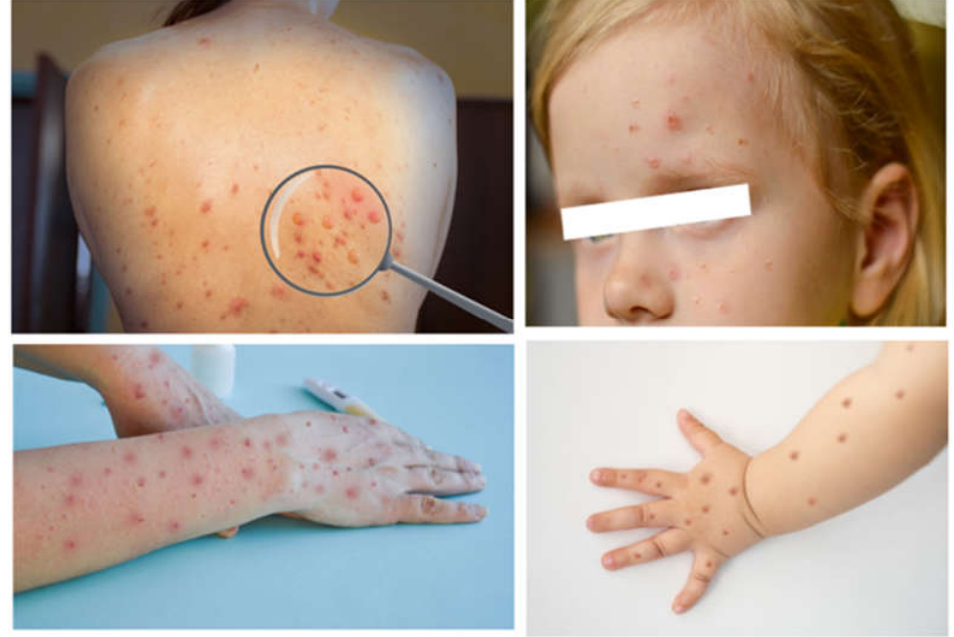
Figure 1. Diverse phases of the evolution of the monkeypox rash in adults ( left ) and in children ( right ) Photo credit: Shutterstock.